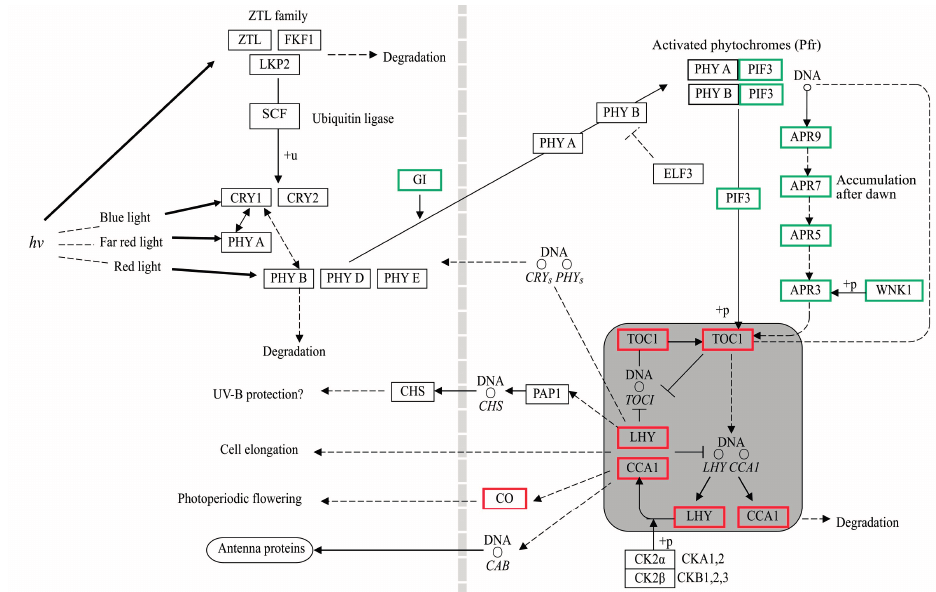
Figure 9. Circadian rhythm pathway in P. fortunei . Genes in boxes are differently expressed. Red boxes indicate up-regulated or induced genes in the infected seedlings. Green boxes indicate down-regulated